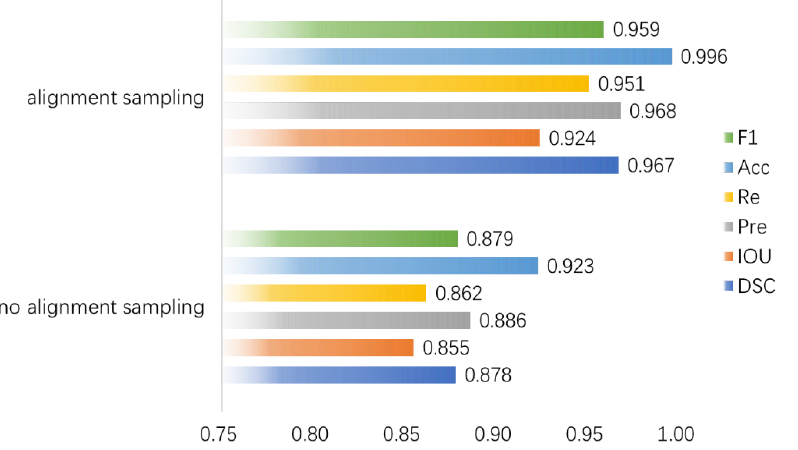
Figure 9. The performance of the overall model for each evaluation metric with and without align- ment sampling in the RoI Align operation. ment sampling in the RoI Align